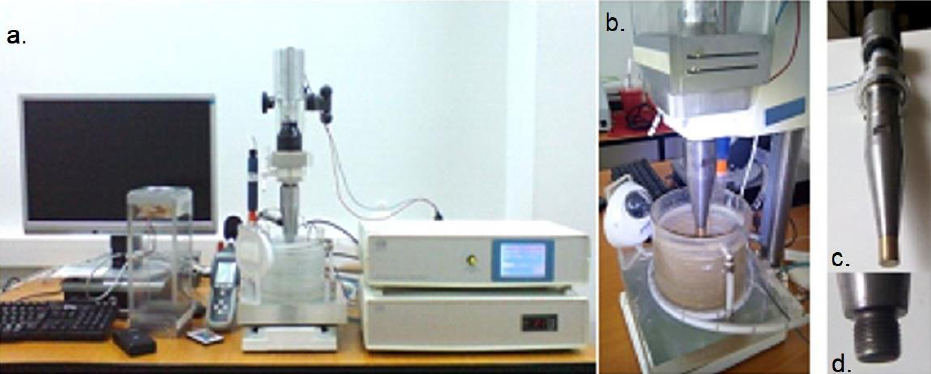
Figure 2. The vibrating device with piezoceramic crystals: ( a ) overview of the device with the computer control system; ( b ) image during the cavitation test (sample immersed in water); ( c ) mechanical vibration system (piezoceramic transducer with amplitude amplification system (buster, sonotrode and cavitation sample); ( d ) threaded end of the sonotrode for fixing the sample. The functional parameters of the device are: